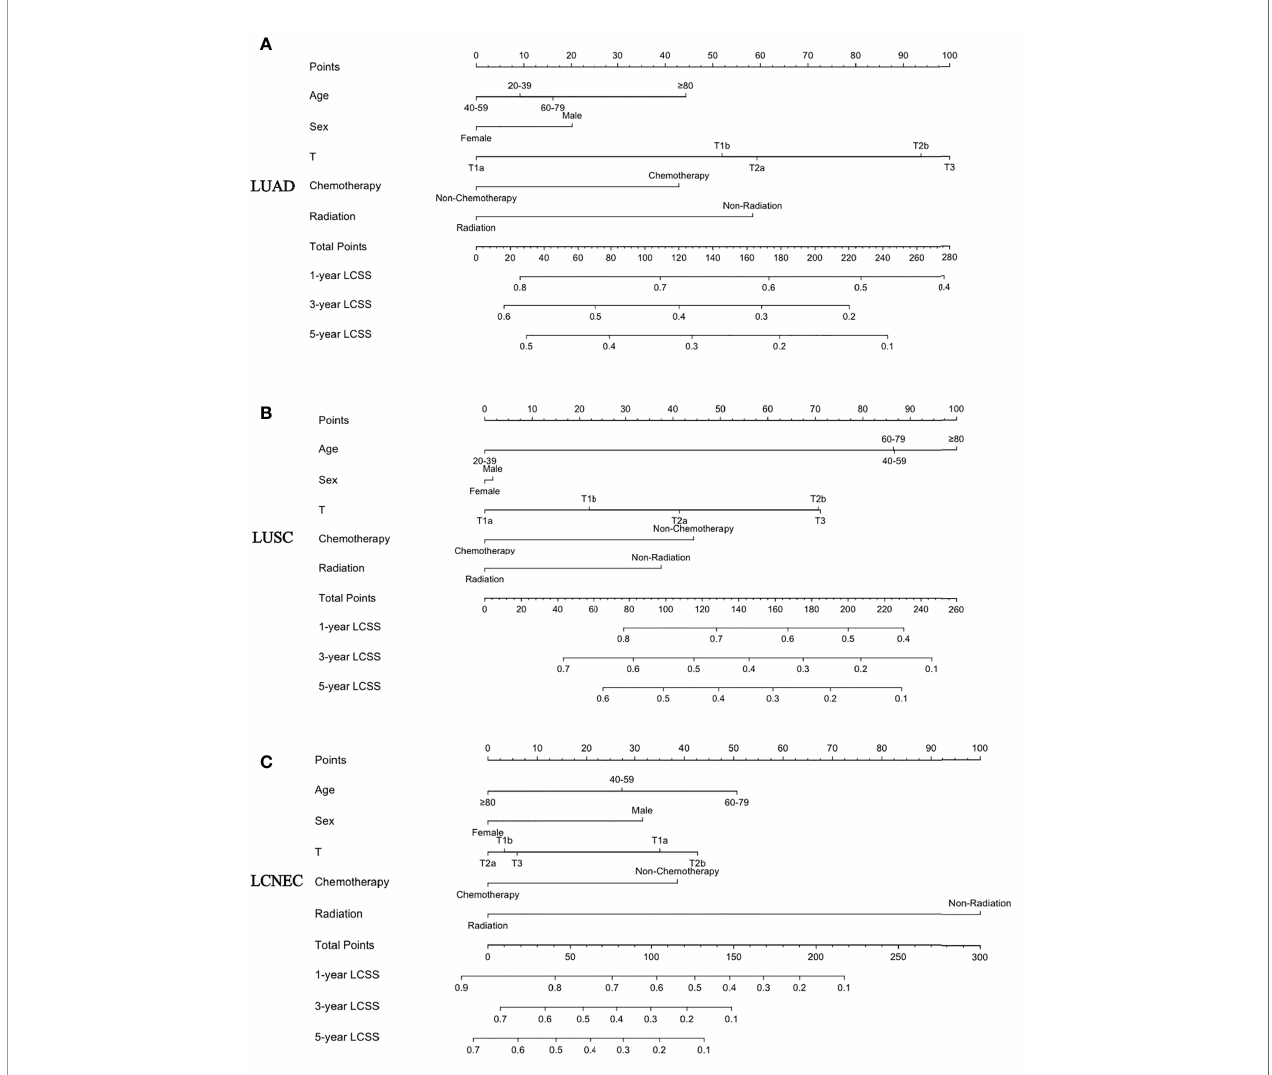
FIGURE 4 | A nomogram for the prediction of 1-, 3-, and 5-year LCSS rates: (A) LUAD, (B) LUSC, and (C)